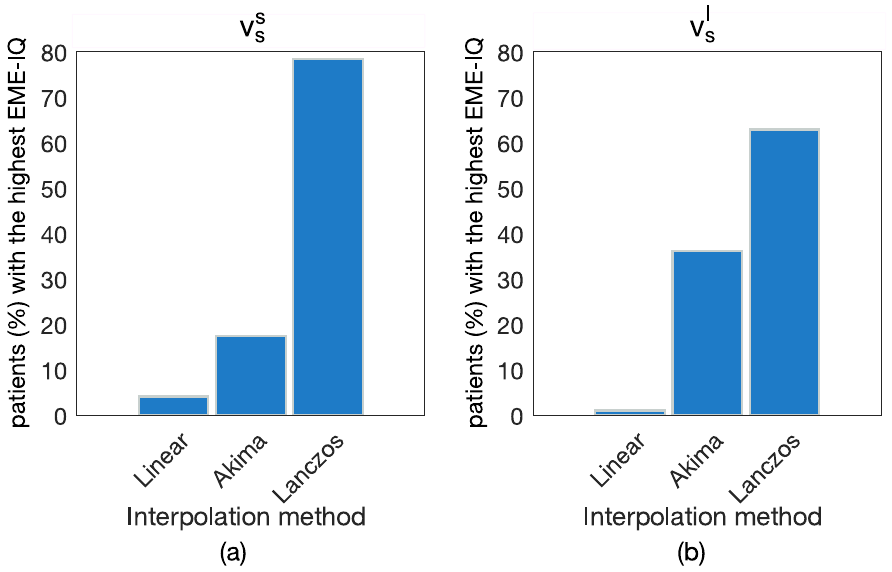
Figure 2. Comparison of linear, Akima, and Lanczos interpolation methods, based on the percentage of patients receiving the highest EME-IQ score, for both upsampling ( a ) and downsampling ( b ) respectively at the s v l smallest ( v s ) and the largest ( s ) resolutions of the CT image dataset. The Lanczos method yielded the highest EME-IQ score in 78 % and 63 % of patients,